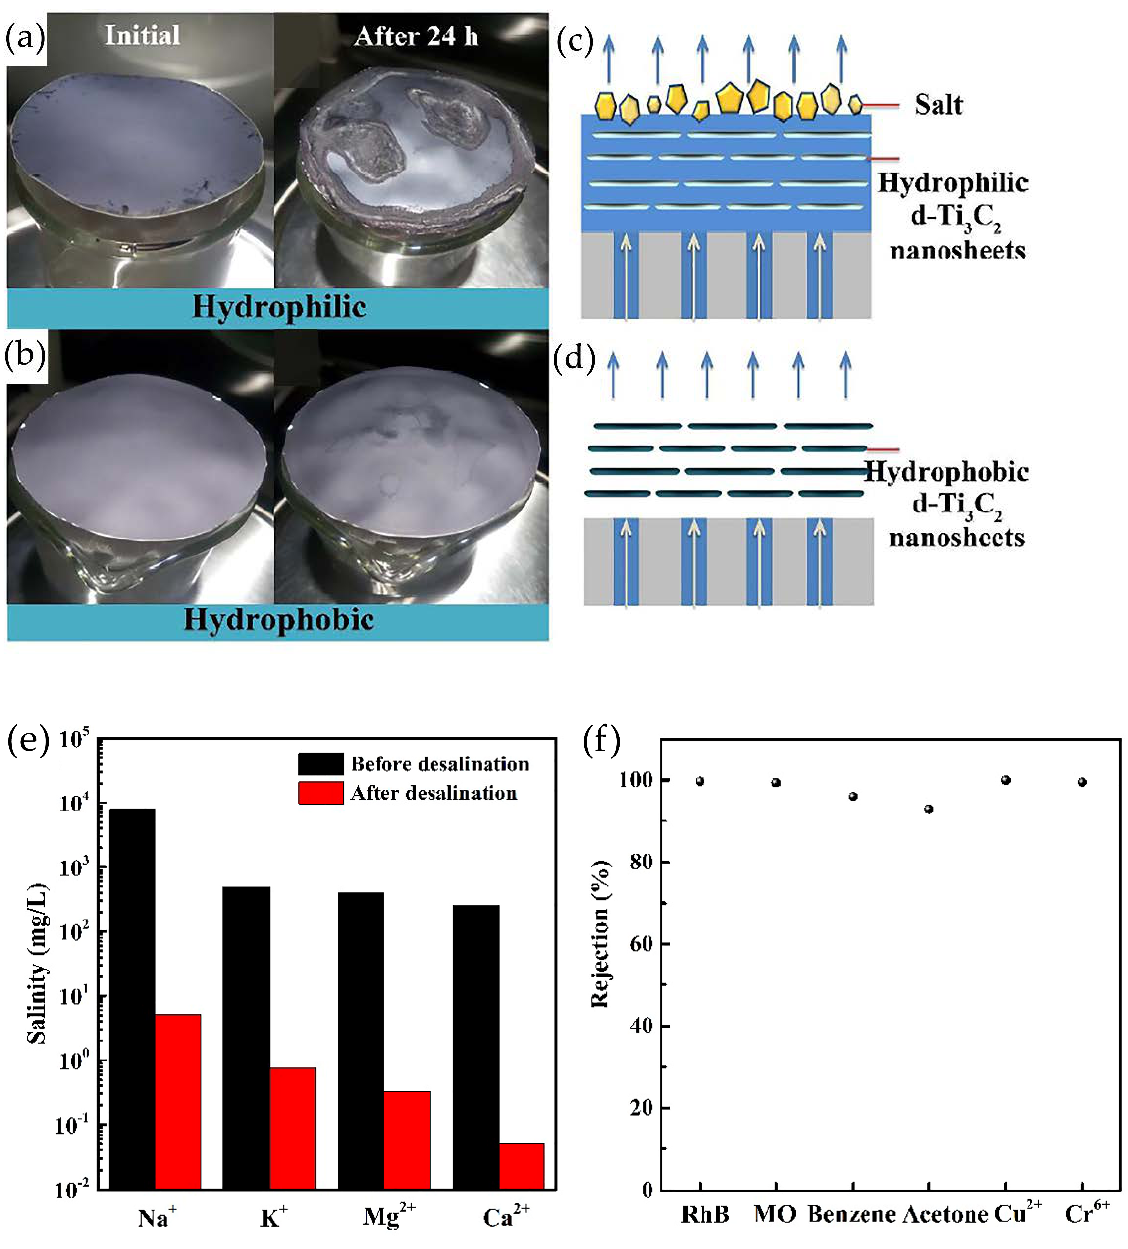
Figure 28. Optical photographs of ( a ) hydrophilic and ( b ) hydrophobic membranes with Ti 3 C 2 before and after 24 h of desalination. Schematic representation of the desalination process by solar steam generation using ( c ) hydrophilic and ( d ) hydrophobic membranes. ( e ) Results of measuring the salinity of Na + , K + , Mg + , and Ca + primary ions before and after desalination. ( f ) Filtration efficiency of organic substances and heavy metal ions. Reprinted with permission from [167] 2018 Royal Society of Chemistry.